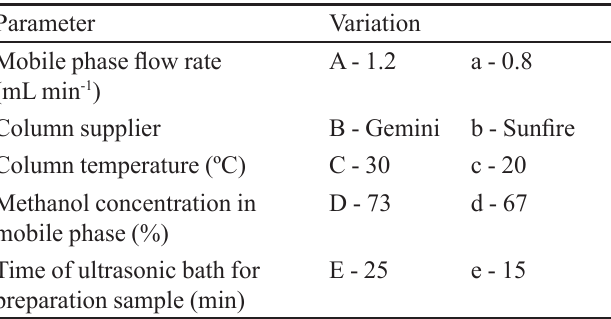
TABLE I - Analytical parameters and variations to evaluate the robustness of the chromatographic method for DP quantification